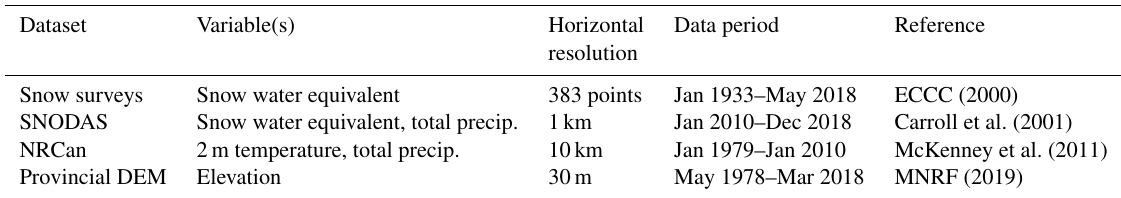
Figure 1. (a) Relative mean bias between SNODAS and in situ SWE aggregated for each snow survey site (colored points). Thicker black contours show the boundaries of the three drainage basins in the water balance analysis (Sect. 4.1). (b) Daily mean SWE on ground estimates from all in situ survey sites and SNODAS, taken biweekly from November to May [2011–2017] at 383 locations across Ontario. Table 1. Descriptions of the primary datasets used in our bias-correction methods, including relevant regression variables, their resolution, observational record coverage and data